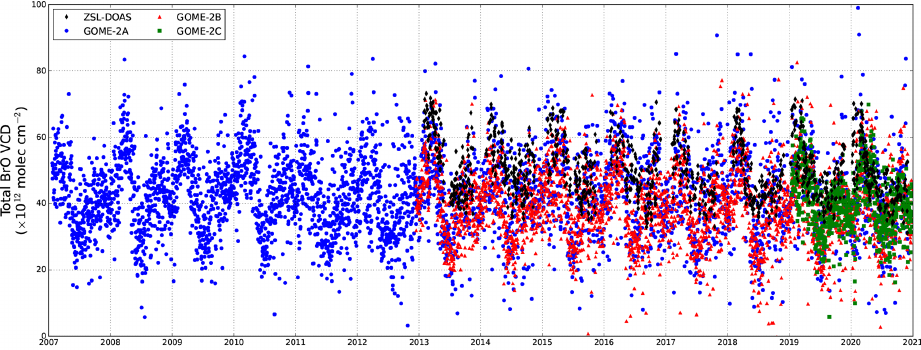
Figure 23. Time series of total column BrO measured by GOME-2A (blue), GOME-2B (green), GOME-2C (red), and ZSL-DOAS (black) at Harestua,